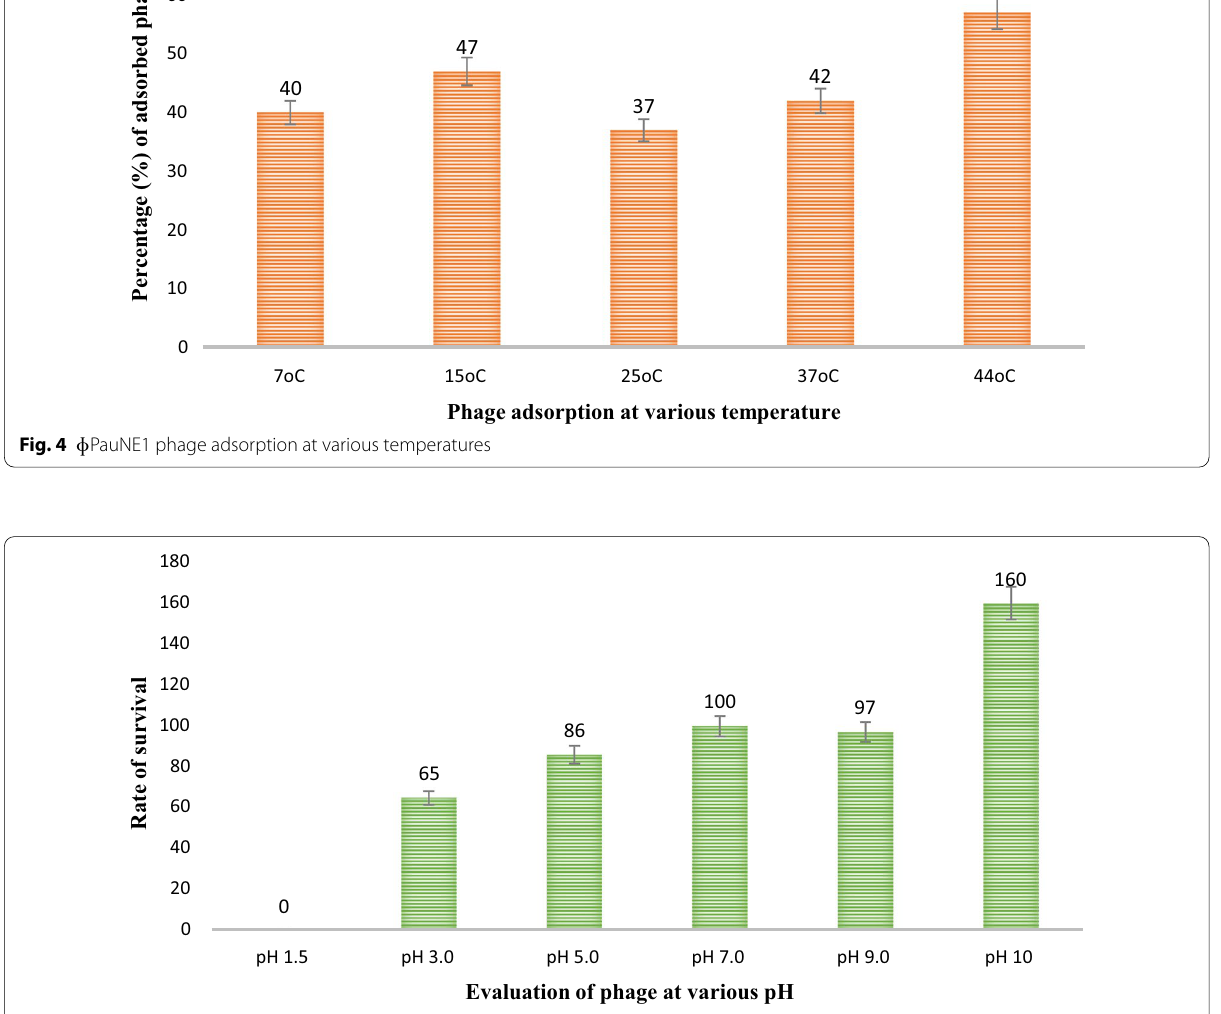
Fig. 5 ɸ PauNE1 phage survival rate at various